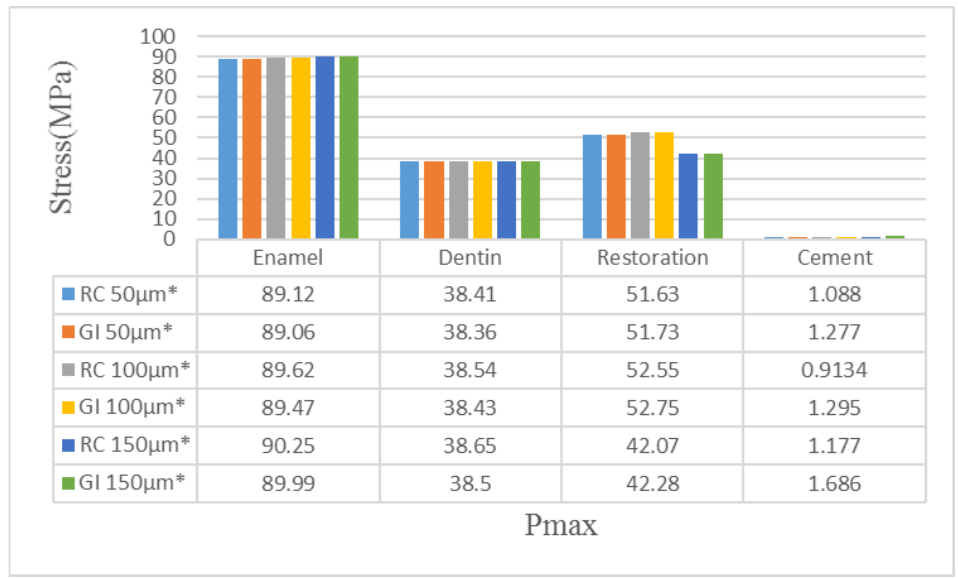
Figure 11. Maximum principal stress distribution in restorations with cements of different thickness (* 35 GPa Young’s modulus of amalgam).